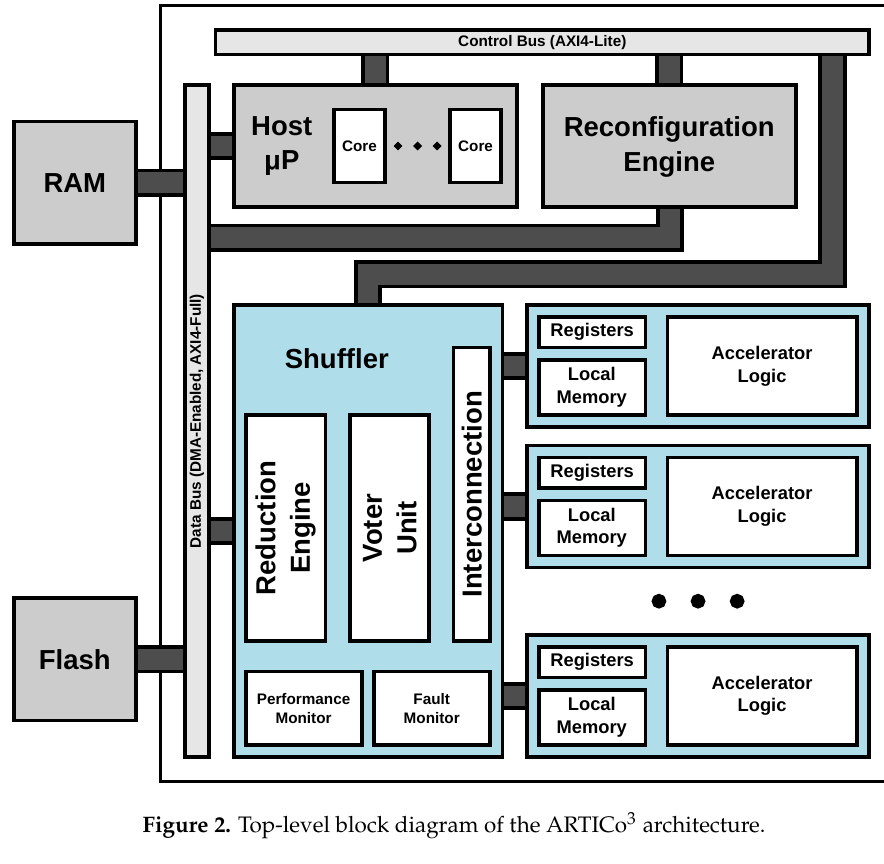
Figure 2. Top-level block diagram of the ARTICo 3 architecture.